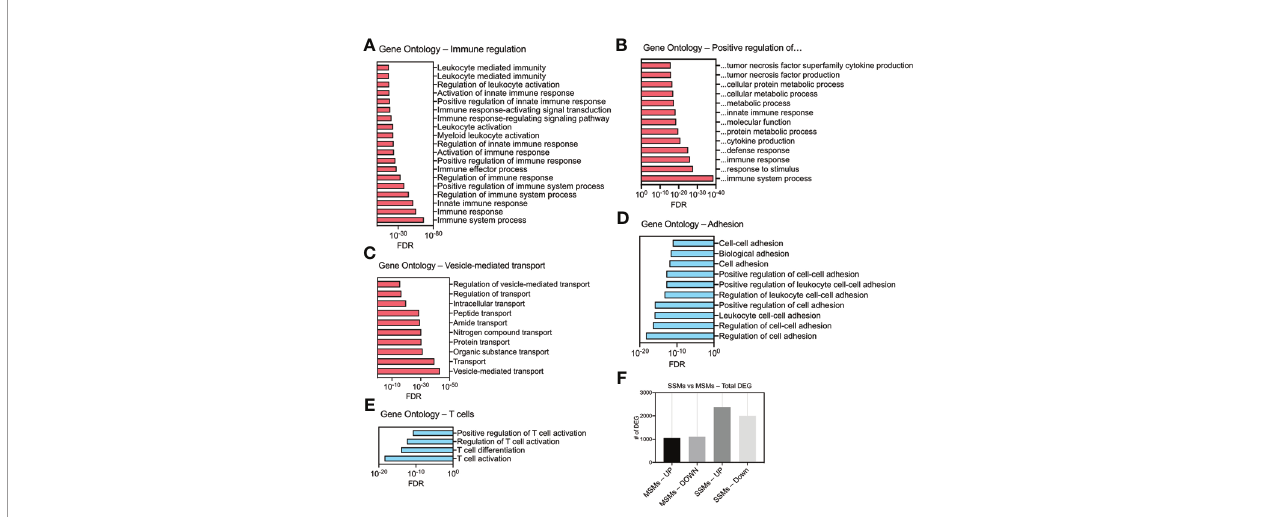
FIGURE 3 | Gene ontology analysis of differentially expressed genes (DEG) in SSMs between tumor-draining and non-draining lymph nodes. (A) Gene Ontologies related to immune regulation. (B) Gene Ontologies related to positive regulations. (C) Gene Ontologies related vesicle-mediated transport. (D) Gene Ontologies related to cell adhesion. (E) Gene Ontologies related to T cell biology. Gene Ontologies enriched in genes up-regulated between SSMs from tumor-draining and non- draining lymph nodes are shown in red. Gene Ontologies enriched in genes down-regulated between SSMs from tumor-draining and non-draining lymph nodes are shown in blue. Genes with a p-adjusted value < 0.01 and a mean expression level > 100 reads were used. (F) Total number of up-regulated and down-regulated DEG in the two macrophage subsets between tumor-draining and non-draining lymph nodes.